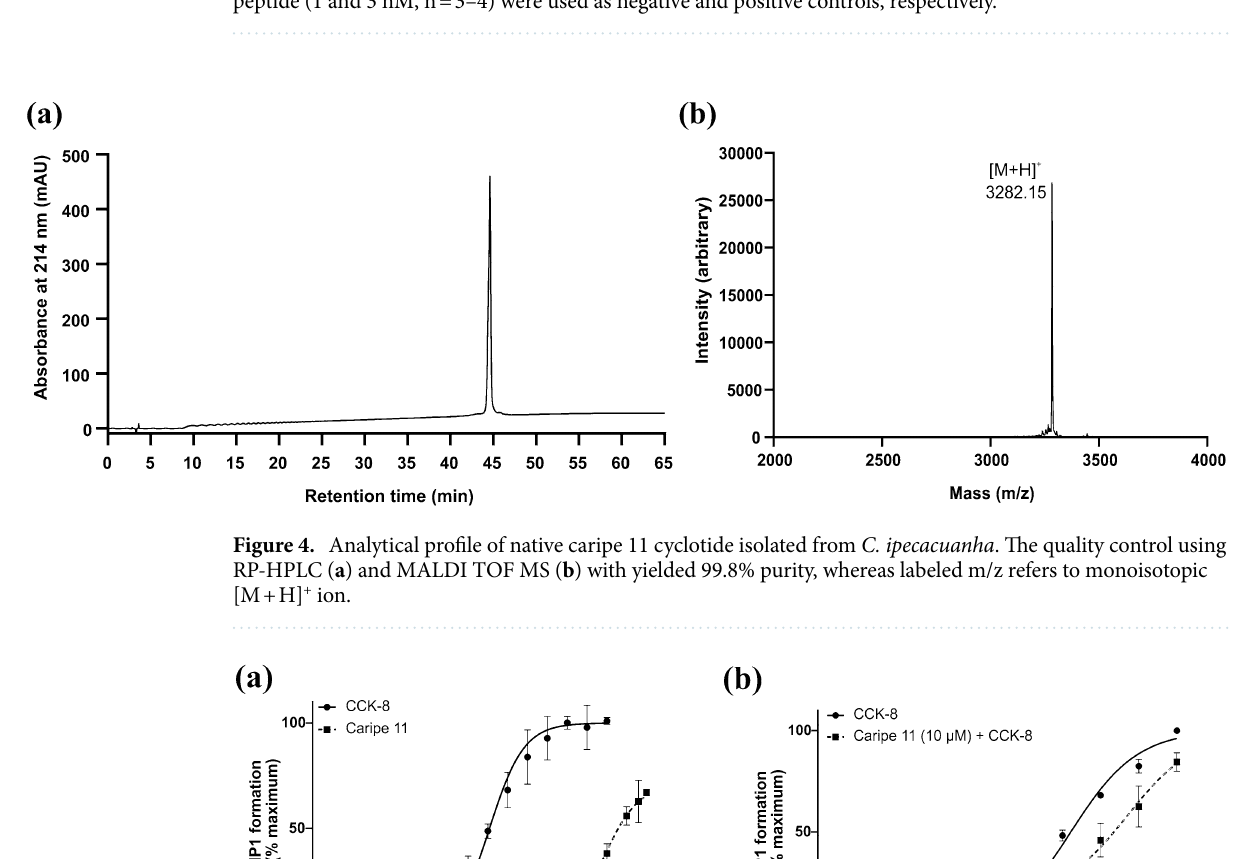
Figure 3. Pharmacological activity of the plant extracts at the CCK 2 R. Agonist efficacy of the plant extracts of C. ipecacuanha (Caripe), O. affinis (Oaff), and V. tricolor (Vitri) were measured by IP1 quantification (fold difference over baseline). Receptor activation was presented as ‘fold difference over baseline’, and data were expressed as mean ± SD (n = 4–5, except Caripe 300 µg/mL is n = 2). Stimulation buffer (not shown) and CCK-8 peptide (1 and 3 nM, n = 3–4) were used as negative and positive controls, respectively.